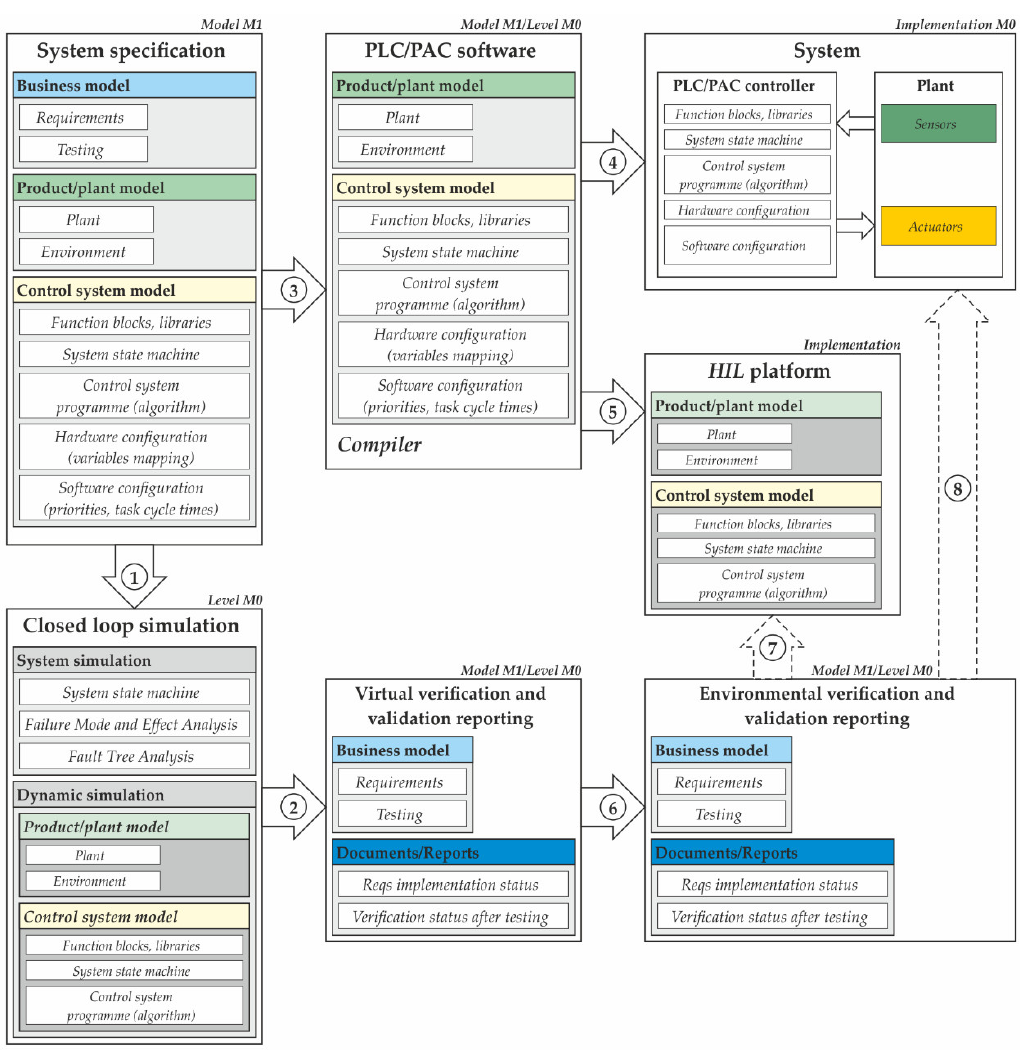
Figure 2. The fully-featured (ideal) Model-Based Design framework/toolchain/workflow. (1) automatic generation of simulation files [20,24,25]; (2) generating documentation from simulation tests; (3) au- tomatic code generation for PLC/PAC [23,26,27]; (4) programming the control platform; (5) Hardware- In-the-Loop testing [28–30]; (6) virtual testing used to validate of the solution [7,18]; (7,8) conducting real-time testing for final system approval.